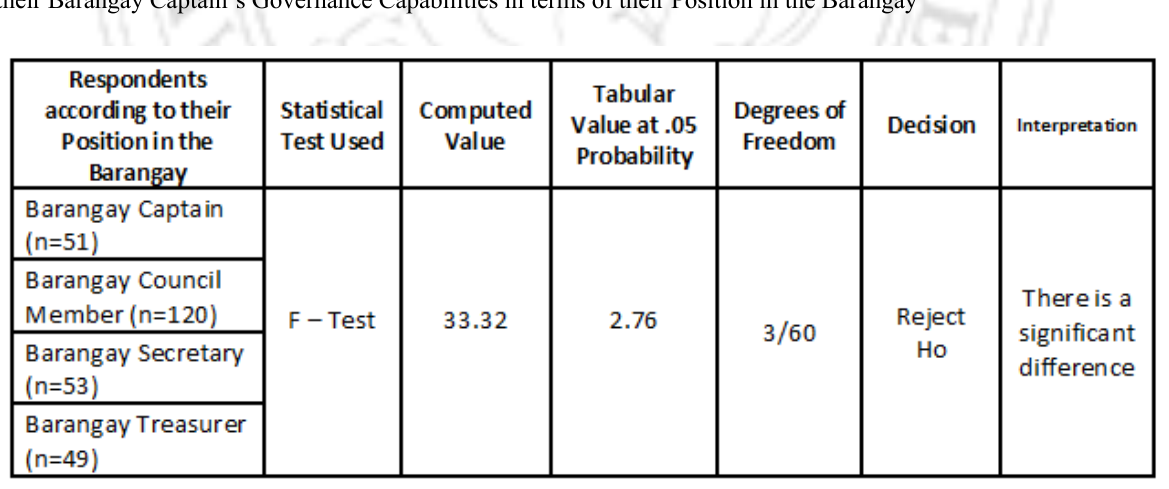
Table 4. Test of significant difference in the Summary Responses of the Respondent-Barangay Officials regarding their Barangay Captain’s Governance Capabilities in terms of their Position in the